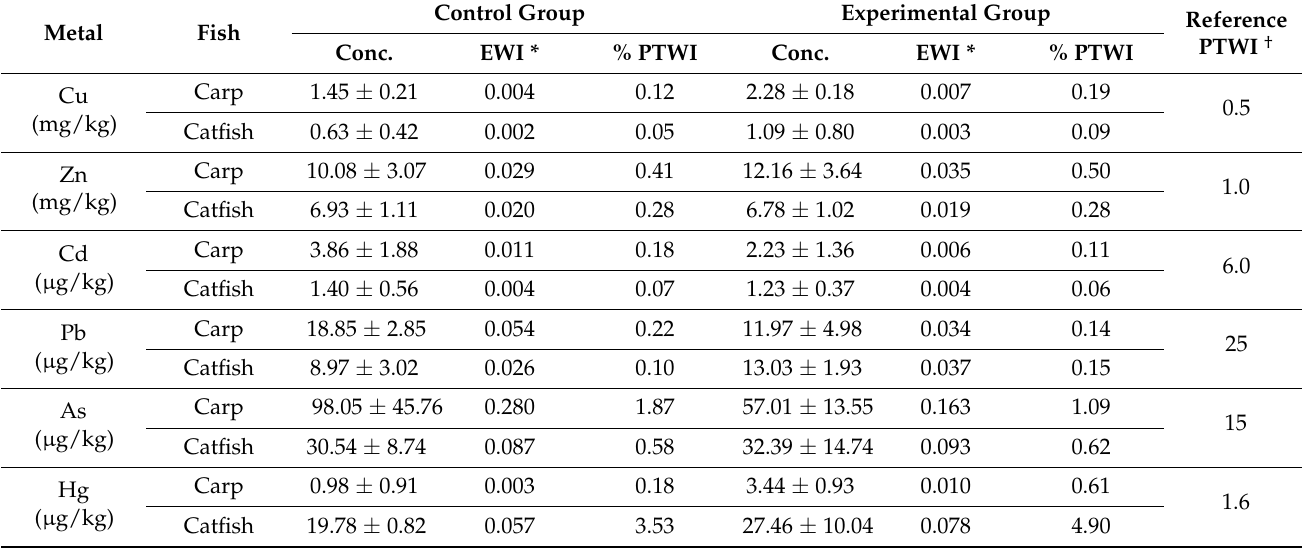
Table 5. Mean concentration (ww) of metals in fish muscle at consumption size in experimental and control groups. Estimated weekly intake (EWI) and contribution to Provisional Tolerable Weekly Intake (%PTWI) through consumption of cultured fish. Control Group Experimental Group Reference Metal Fish